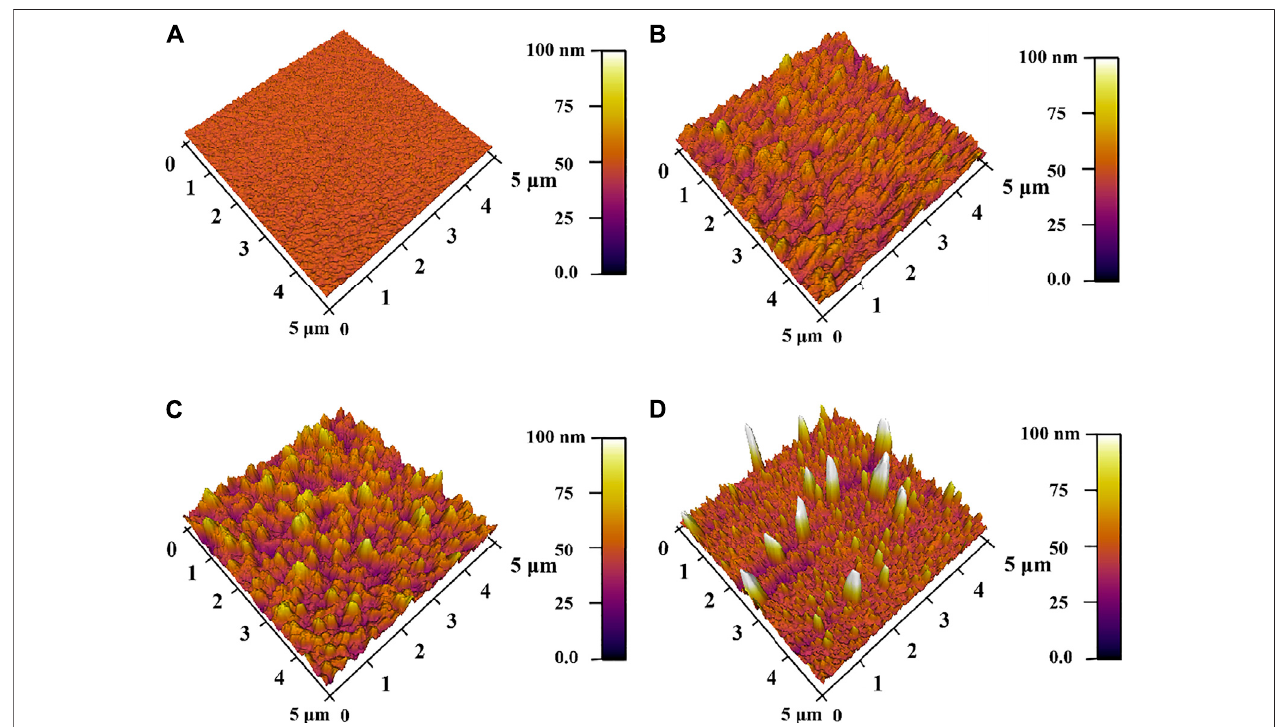
FIGURE 4 | Three-dimensional AFM images of the absorber CAA before annealing (A) and after annealing at 700 o C (B) , 800 o C (C) , and 900 o C (D) in vacuum for 100 h.